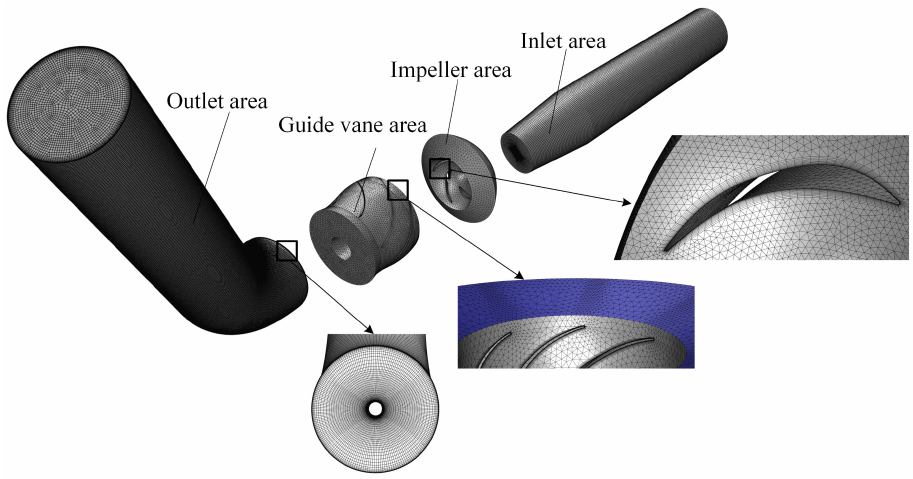
Figure 2. Mesh generation of the computational